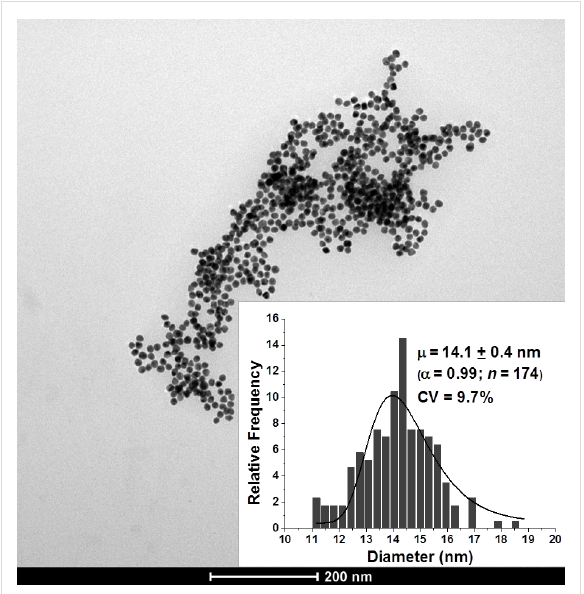
Figure 1: TEM micrograph and dimensional dispersion histogram (inset) of bare AuNPs.